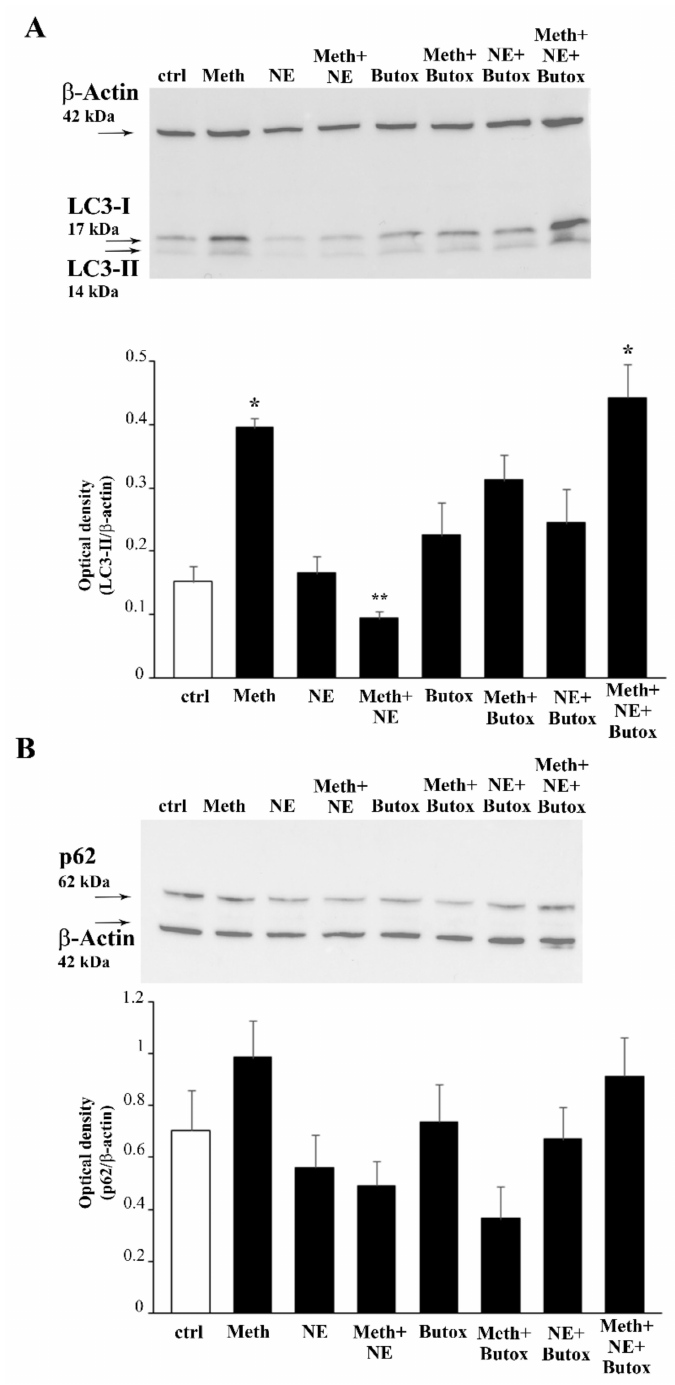
Figure 12. Opposite effects of NE and the β 2-AR antagonist butoxamine on the LC3-II and p62 accumulation induced by Meth. Western blot for the autophagy markers LC3-I and LC3-II ( A ) and p62 ( B ) are reported along with the related optical densities. (DF = 7). * p < 0.05 compared with controls; ** p < 0.05 compared with Meth. Ctrl =